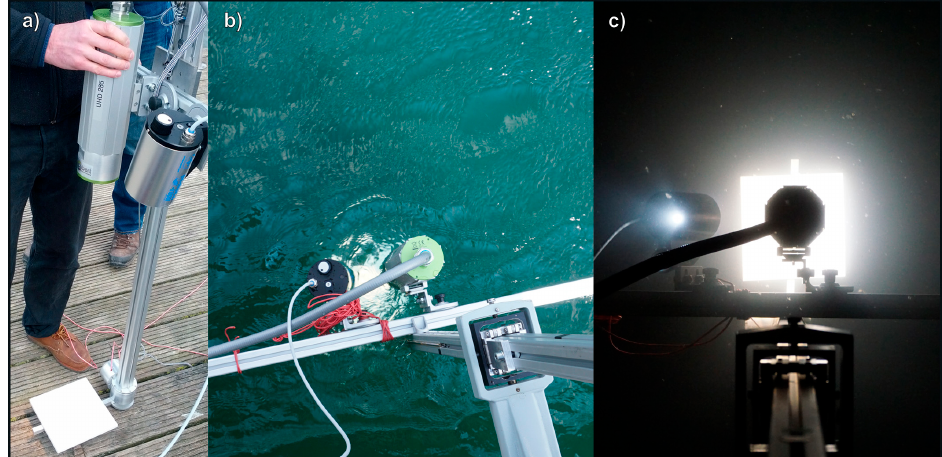
Figure 2. Hyperspectral camera system for underwater measurements: ( a ) camera system mounted on a rack with halogen light source and reference panel; ( b ) in situ measurement of uppermost water layer (0–0.5 m); ( c ) top-down view of night-time measurement in the water column (0.5–1.0